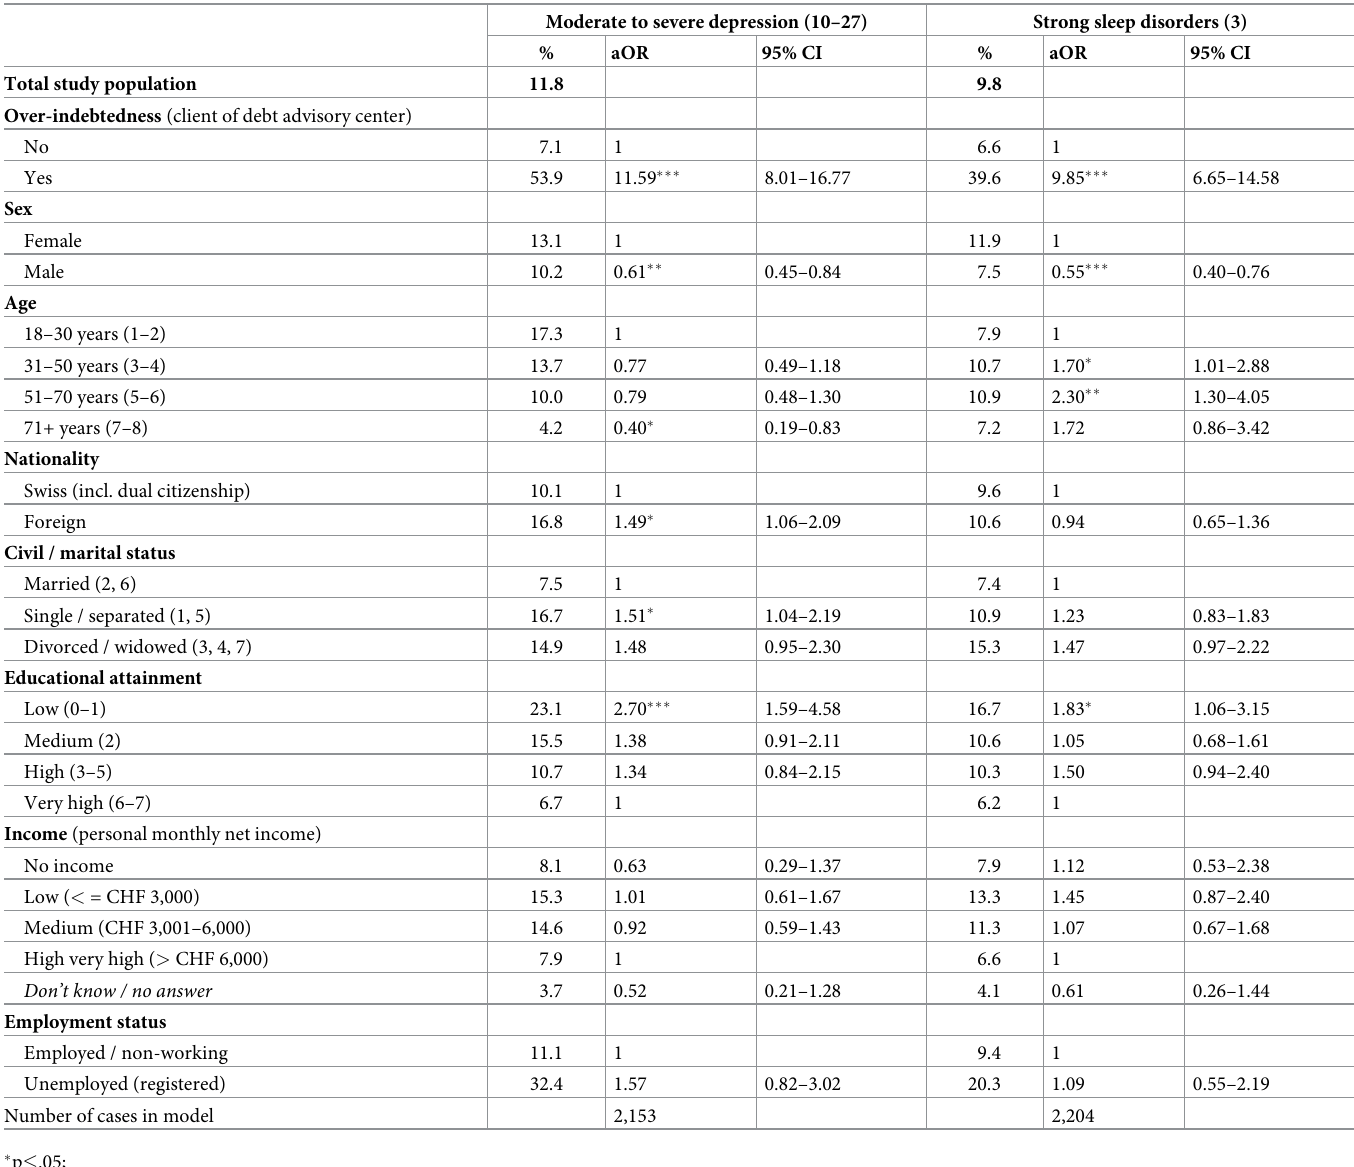
Table 4. Association of over-indebtedness and covariates with mental health problems (N =